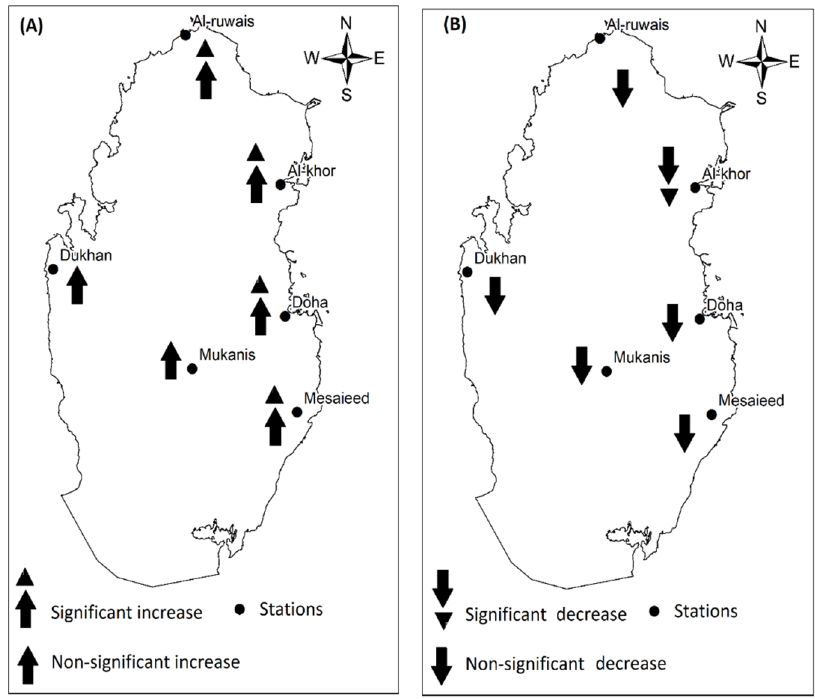
Figure 6. Station wise spatial variability in mean annual temperature ( A ) and total annual rainfall ( B ). Data source QMD.